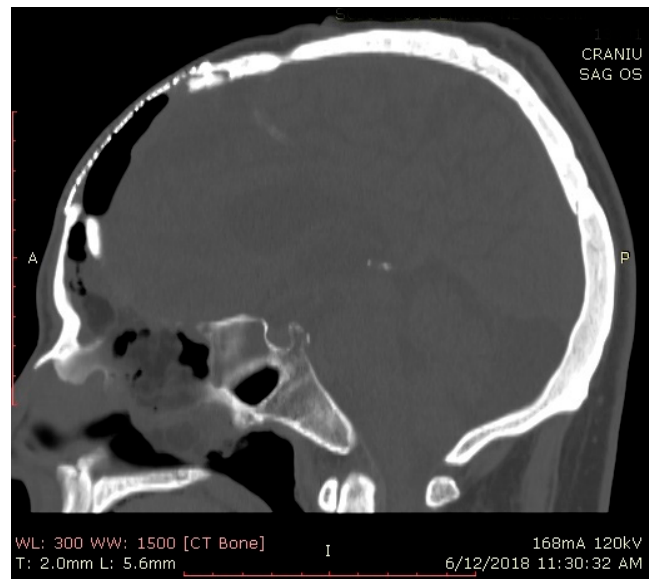
Figure 2. Cranial computed tomography, sagittal plane, of patient (no. 12) with PNC after cranialization.